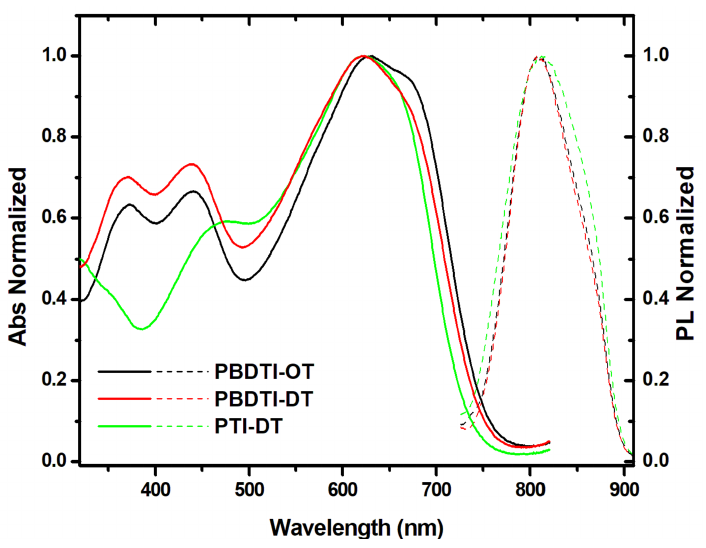
Figure 2. Absorption (solid line) and PL (broken line) spectra of PBDTI-OD (black), PBDTI-DT (red) and PTI-DT